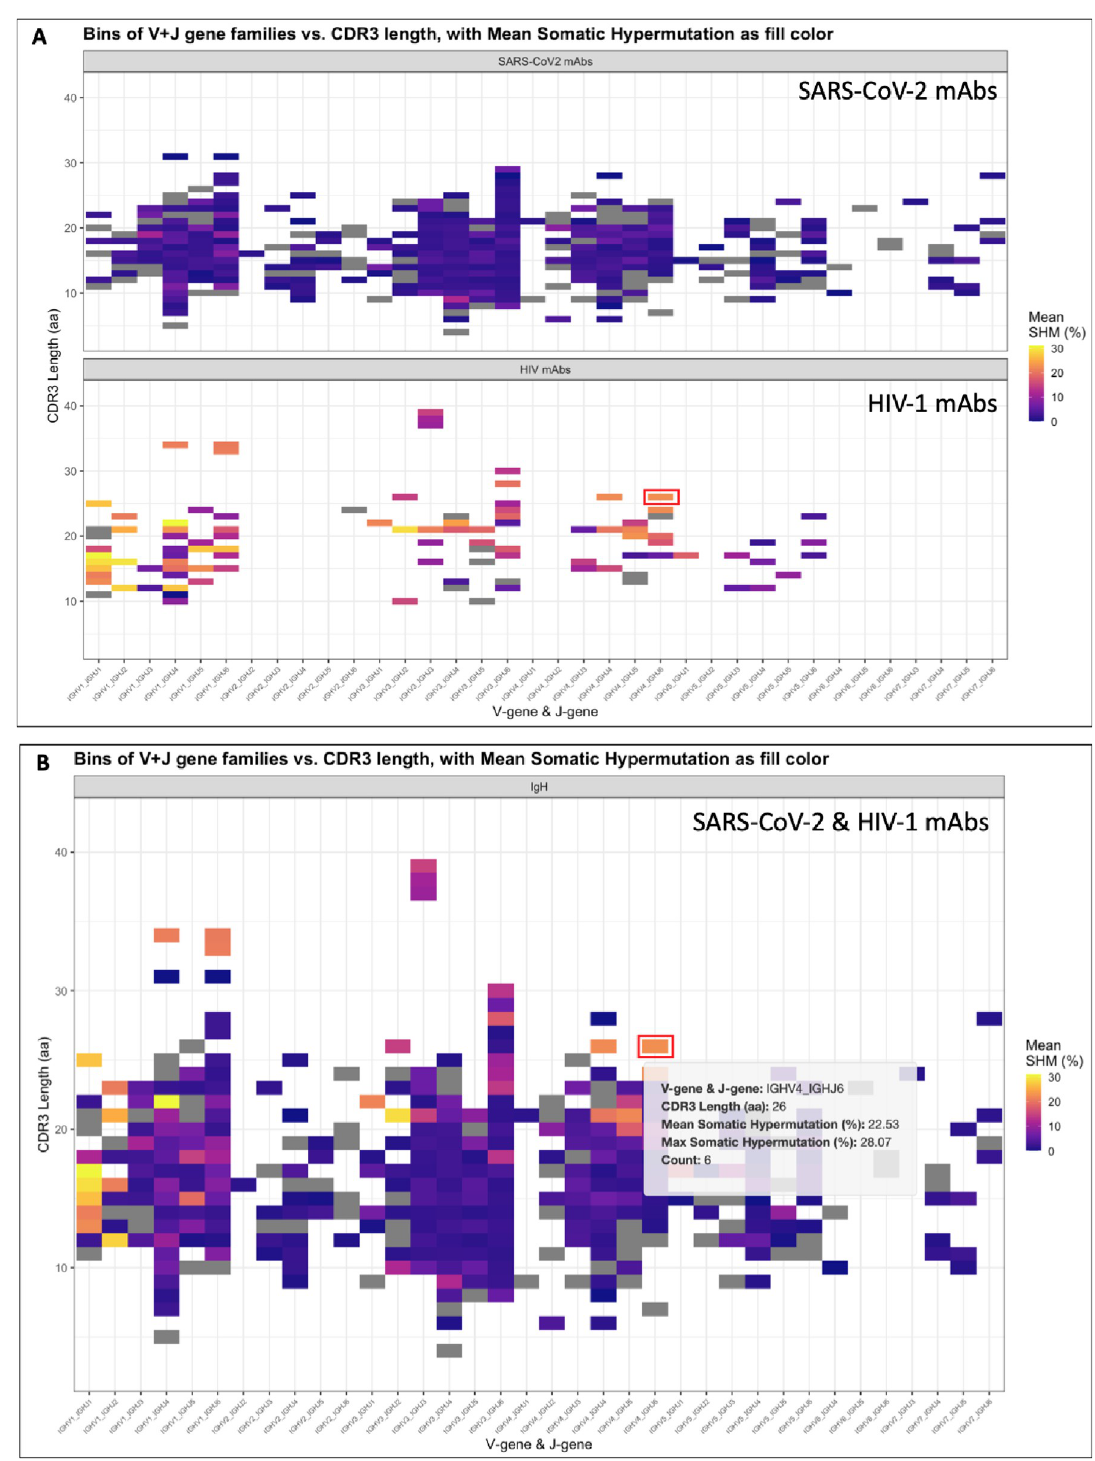
Fig 2. AIRRscape visualization of immune repertoires. Heatmaps comparing characteristics of (A) separate and (B) combined datasets for anti-SARS-CoV-2 and anti-HIV-1 antibodies.